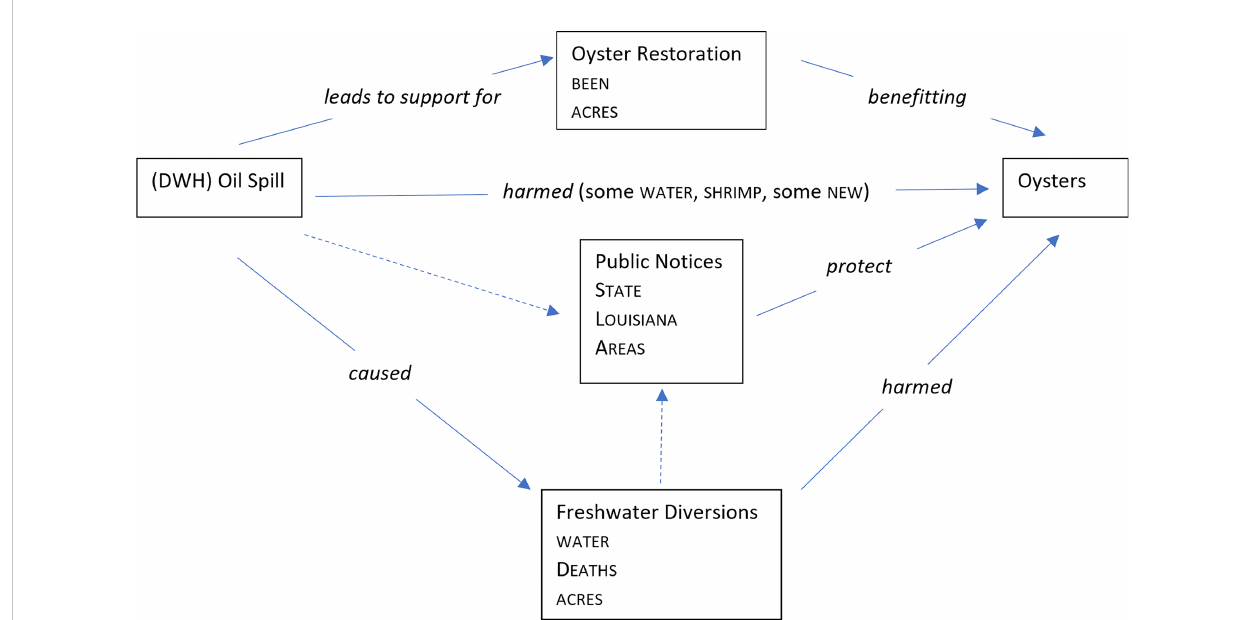
FIGURE 2 Model of principal propositions relating oysters to the Deepwater Horizon Oil Spill in the during-DWH Time span. For each proposition, the salient collocates conveying the proposition are listed at the center of the fi gure. Relationships are described by the italicized verbs within the